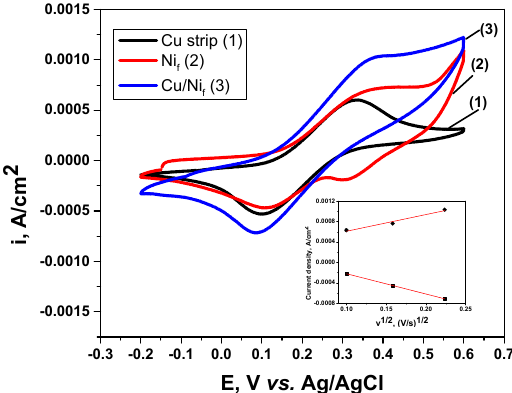
Figure 5. CVs recorded in 5 mM [Fe(CN) 6 ] 3- / 4- in 0.1 M NaOH solution for Cu strip, Ni f and Cu / Ni f electrodes (scan rate = 50 mV s -1 ). The inset shows the dependence of the anodic and cathodic peak currents vs. the square root of the scan rate for the Cu / Ni f electrode.